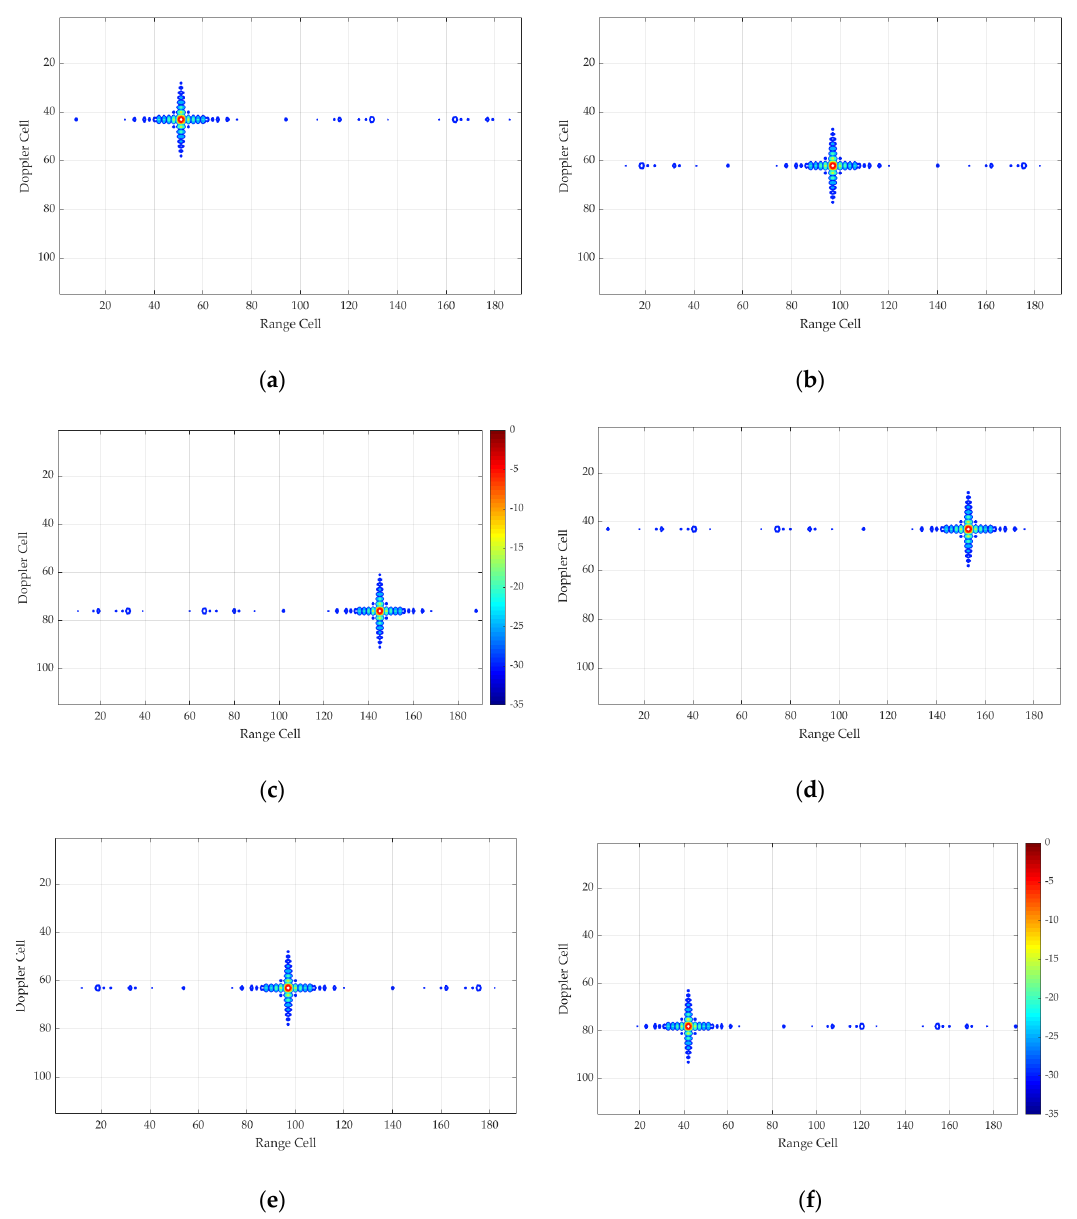
Figure 8. Noise-free range-Doppler maps results: ( a – c ) maps at frame-5, frame-10, and frame-15 with SVN#2 used; ( d – f ) maps at frame-5, frame-10, and frame-15 with SVN#10 used.